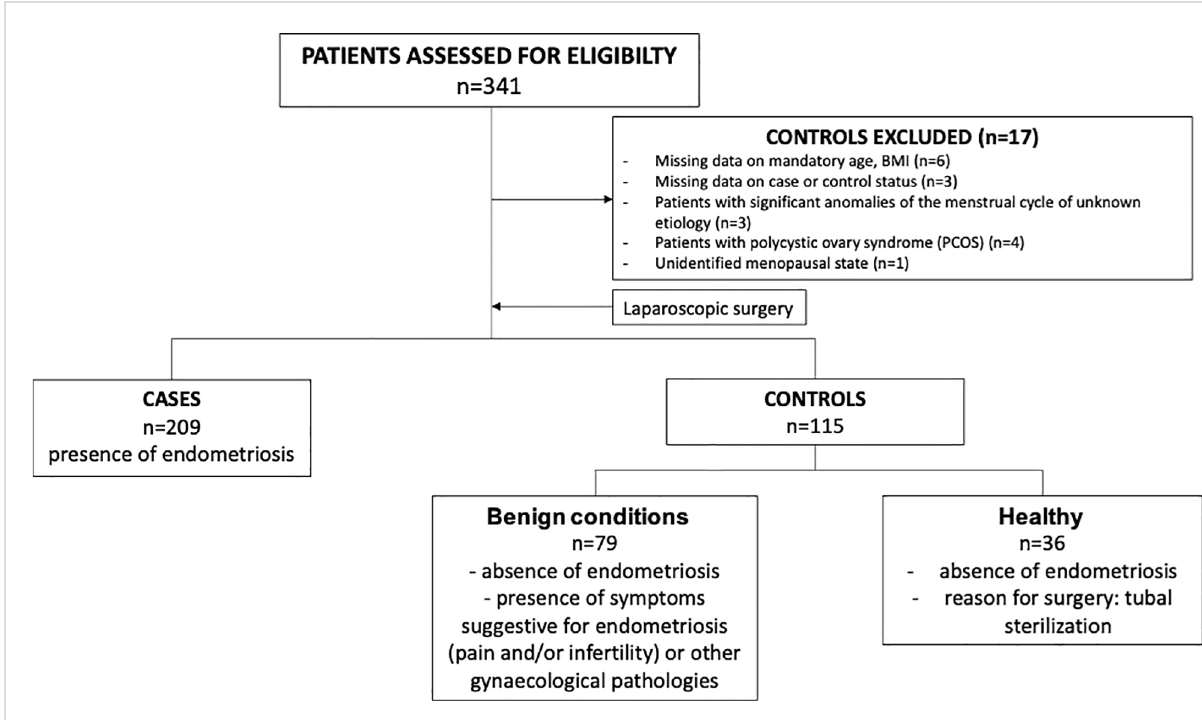
FIGURE 1 Flowchart of patient